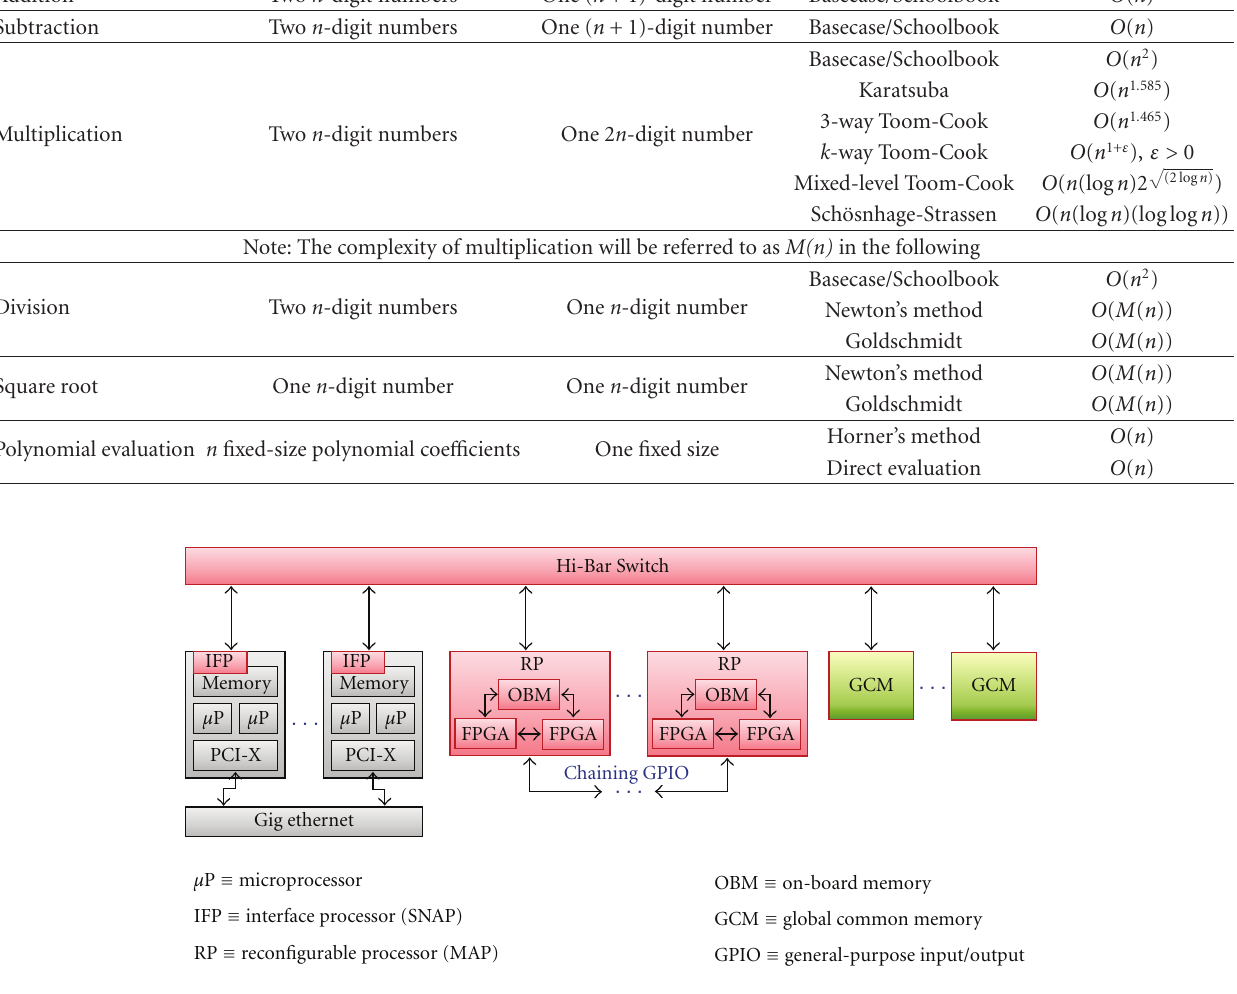
Figure 1: Hardware architecture of